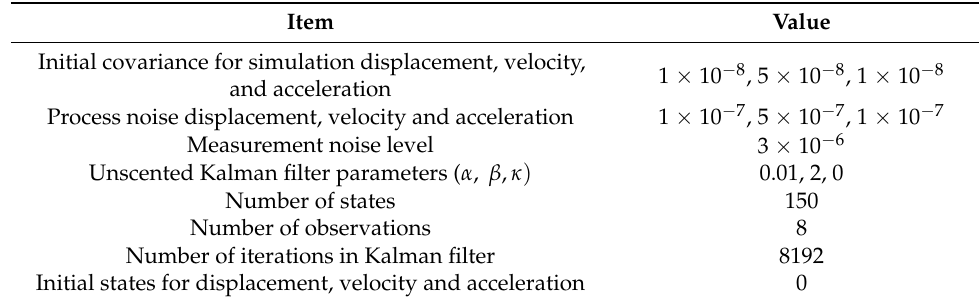
Figure 16. Kalman filter for estimation of the acceleration for test-a. ( a ) brg1-y, ( b ) brg 1-z. Table 5. Final parameter used in Kalman filter.